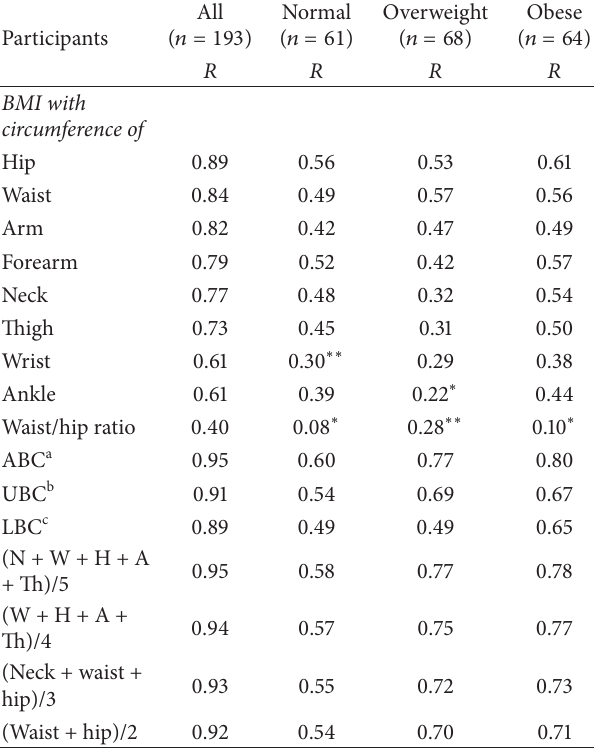
Table 2: Spearman Rank correlations of BMI with body circumfer-